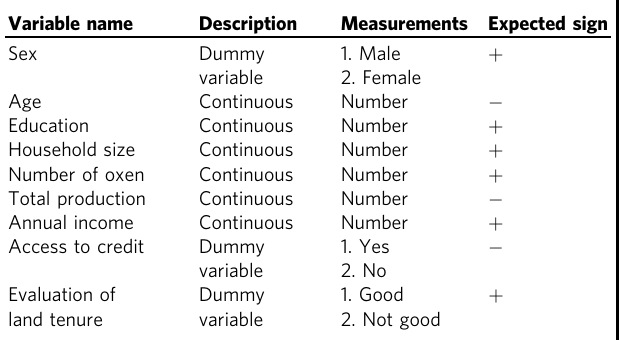
Table 2 Households demographic